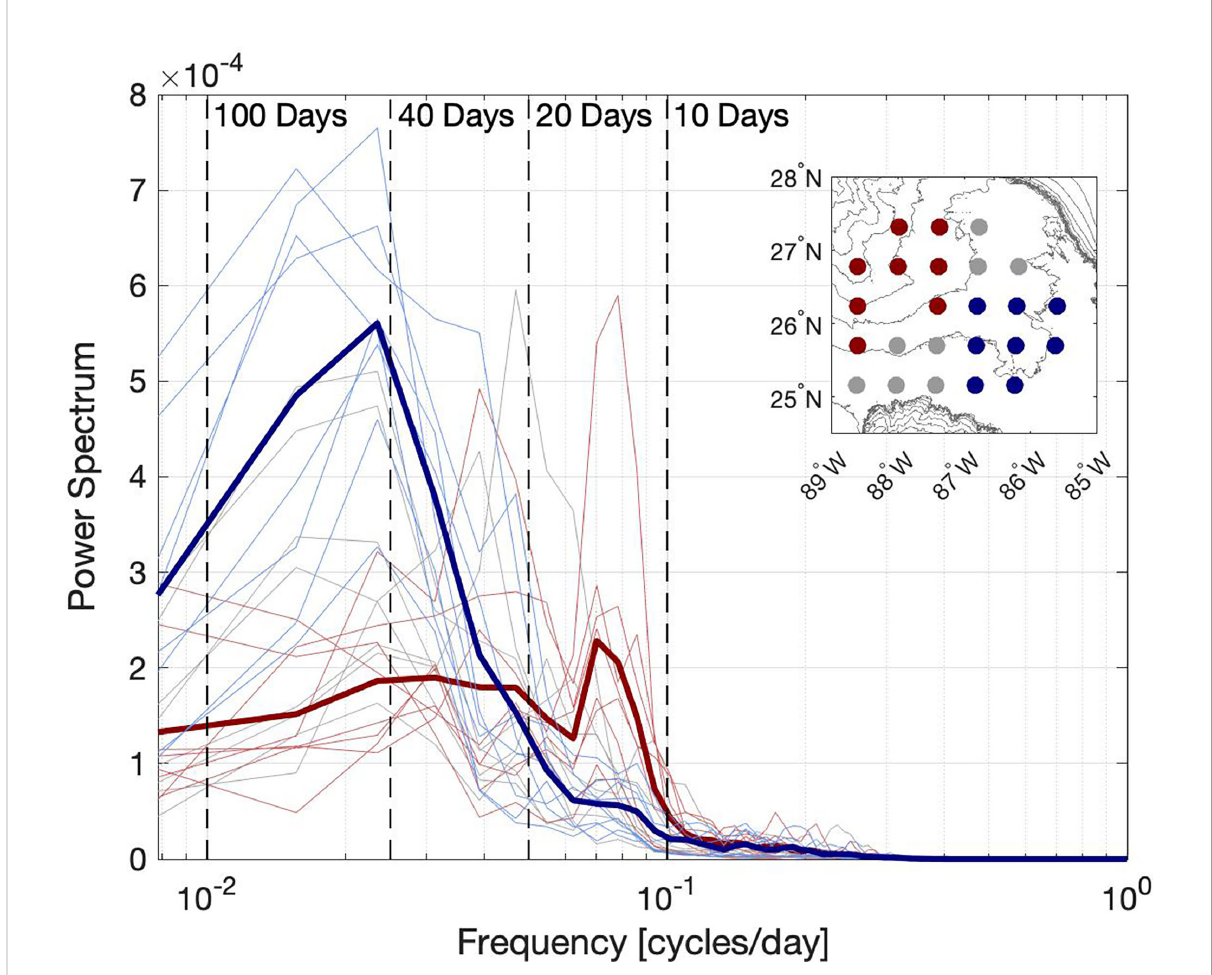
FIGURE 5 Variance-preserving spectra for CPIES bottom pressures, SSH ref in the southeastern (blue) and northwestern corner of the array (red). Remaining instruments are in gray. Individual instruments are in light shades and area averages are in dark bold colors. Frequency limits, labeled by their corresponding period, are denoted by dashed vertical lines. Inset identi fi es sites in the southeastern (blue), northwestern (red) and remaining